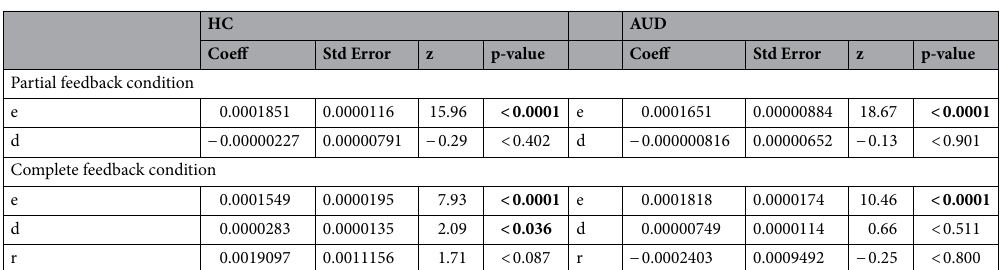
Table 3. Choice behaviour at the WoF task: Model 1. The table reports the results of a model of choice integrating the effects of anticipated disappointment (d) and regret (r) in addition to the maximization of expected value (e). Bold values denote statistical significance at the p < 0.05 level.